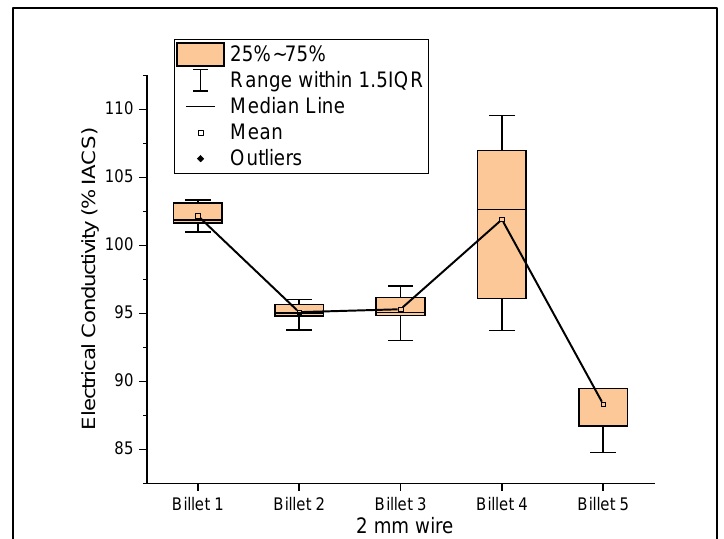
Figure 6 . The electrical conductivity of all billets at a 2 mm thickness.